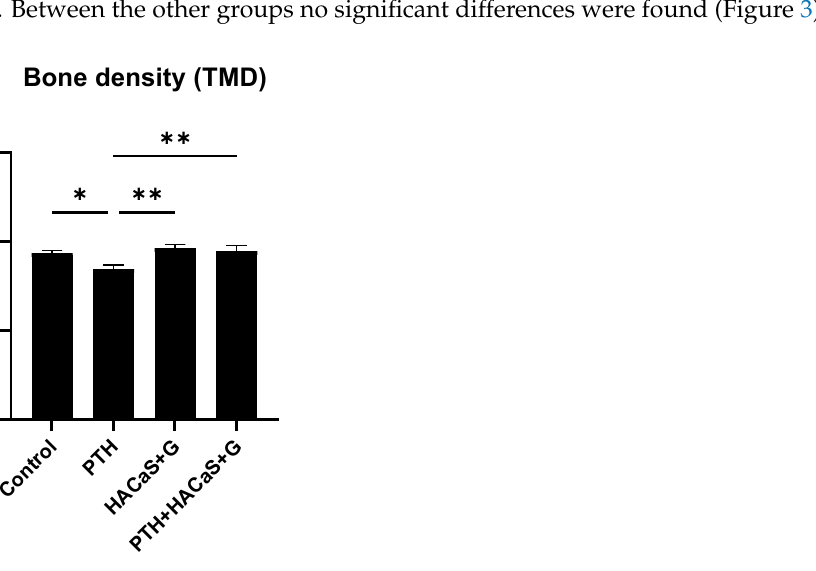
Figure 3. Analysis of bone density (TMD). PTH-treated samples showed less density in comparison to the other groups. * = p < 0.05, ** = p < 0.01.